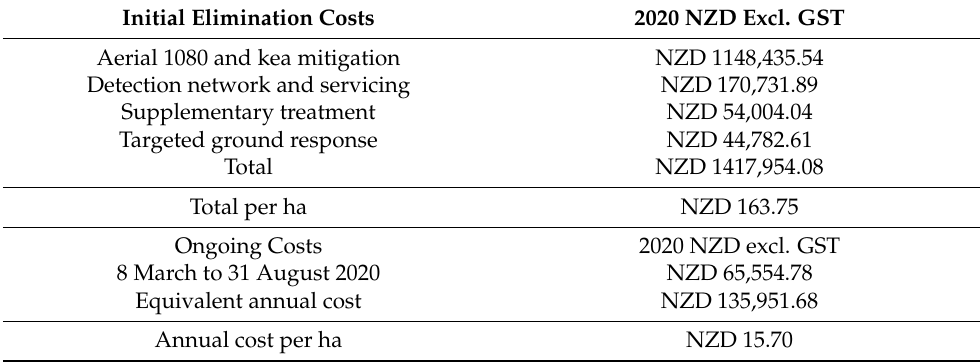
Table 2. Approximate costs of the Perth Valley possum elimination and ongoing response